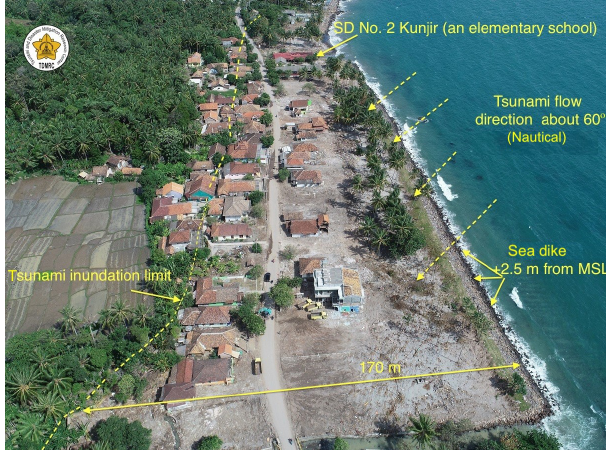
Figure 11. An aerial view from tsunami-affected area around the villages of Batu Balak and Kunyir, Lampung, captured on 31 De- cember 2018 (MSL – mean sea level).